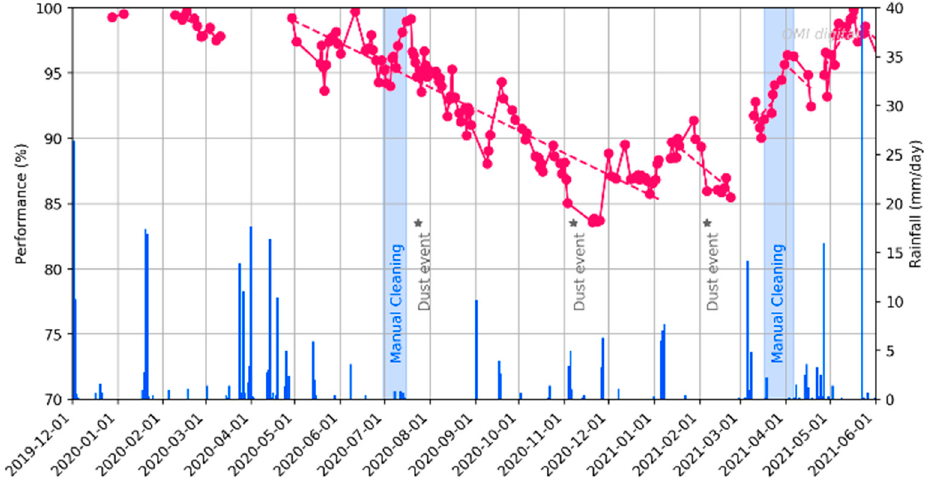
Figure 3. Daily precipitation and performance evolution at a large PV plant in Spain. Magenta: per- formance (%) on sunny days at midday; blue: daily precipitation (mm/day). performance (%) on sunny days at midday; blue: daily precipitation